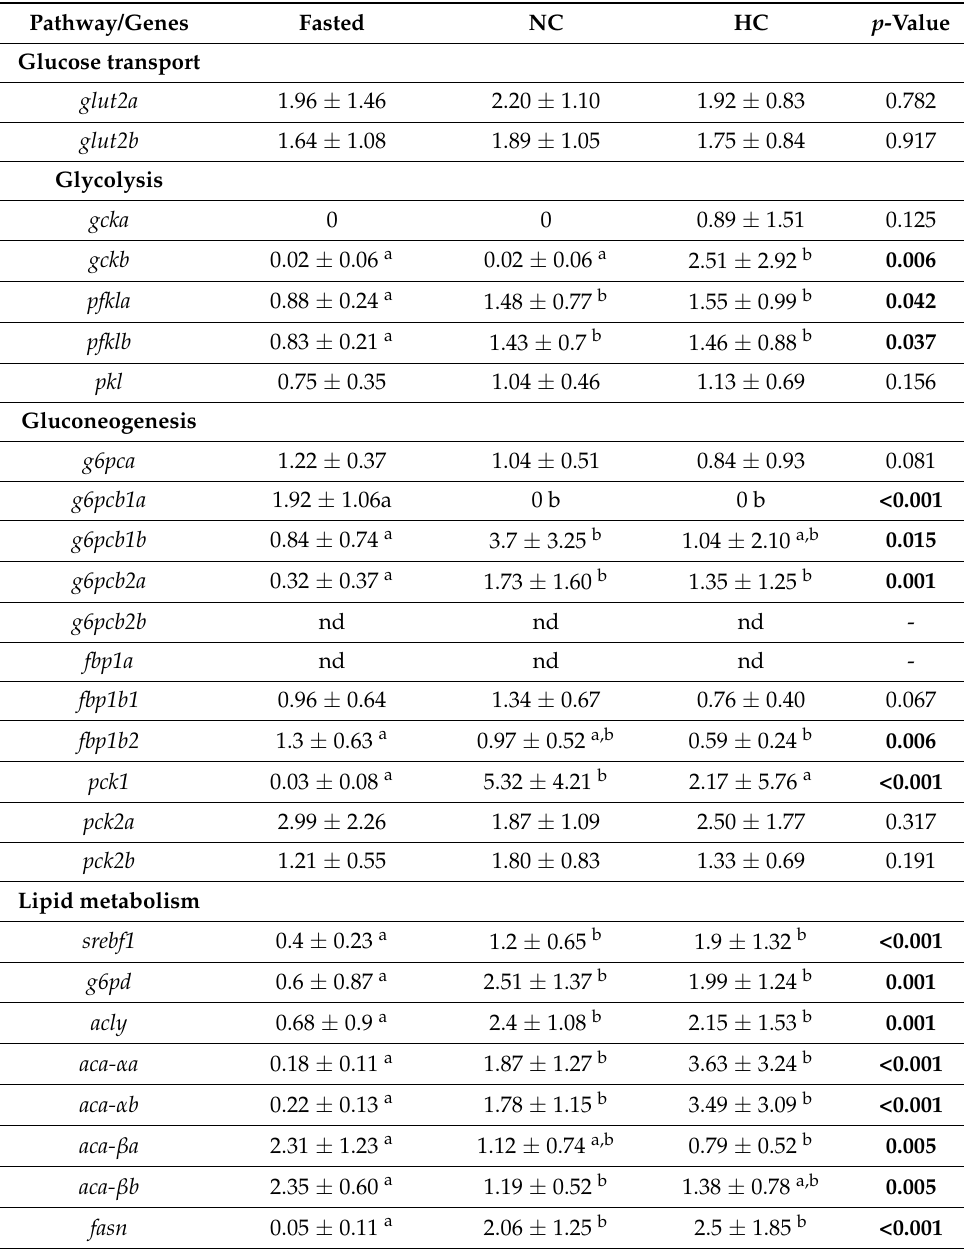
Table 3. Relative mRNA levels of glucose and lipid metabolism-related genes in liver of fasted neo- male rainbow trout (Fasted), fed with a non-carbohydrate diet (NC) or fed with a high-carbohydrate diet (HC). Data are represented as means ± SD ( n = 9 neomales per condition). Genes which have not been detected are represented by “nd”. Data were analysed using one-way ANOVA when condi- tions of application were respected, otherwise the Kruskal–Wallis test was performed. Significant differences of means were analysed using post hoc Tukey’s test and are represented using different letters ( a , b ) and bold p